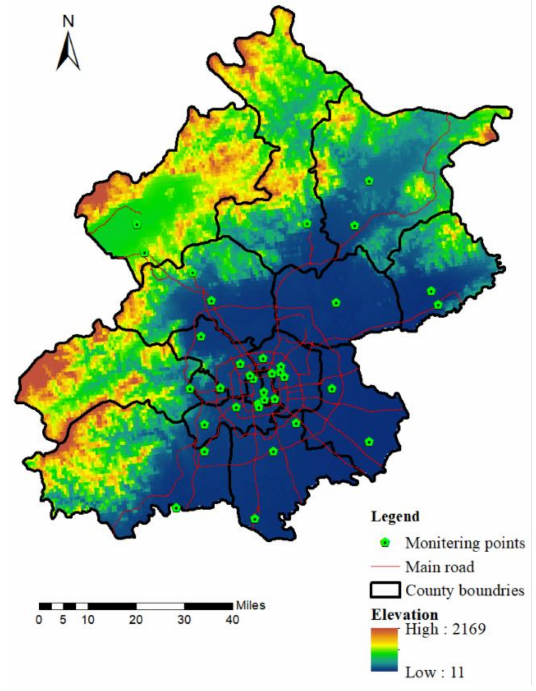
Figure 1. Study area and distribution of the monitoring